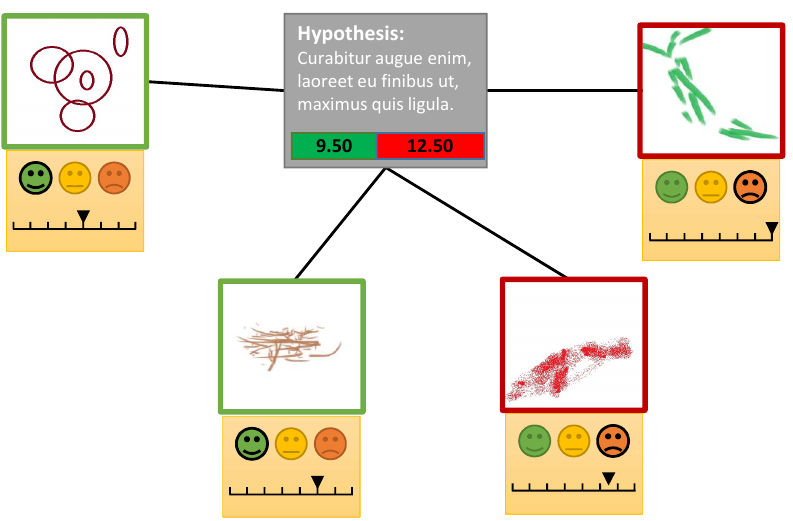
Figure 7: Simplified illustration that describes how ratings are aggregated into an evidence bar in NTE that describes if a hypothesis is rejected or accepted. This fictional example uses lorem ipsum instead of real